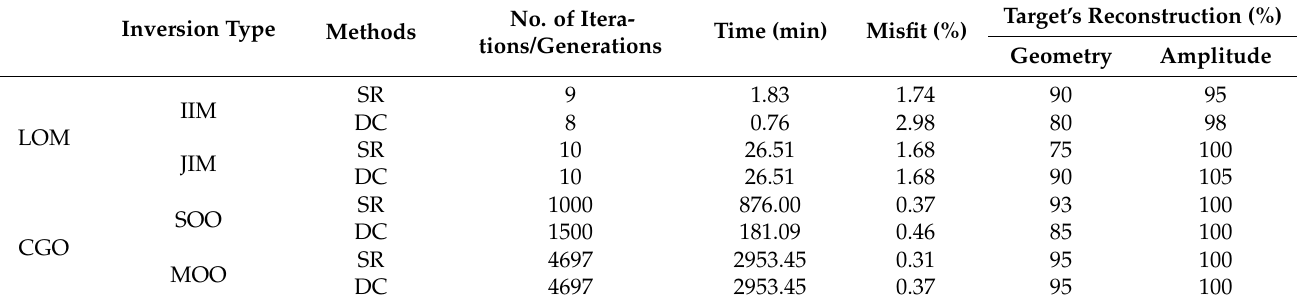
Table 3. Local and combined (local plus global) optimization inversion results parameters for both DCR and SR (synthetic positive anomaly model) methods.